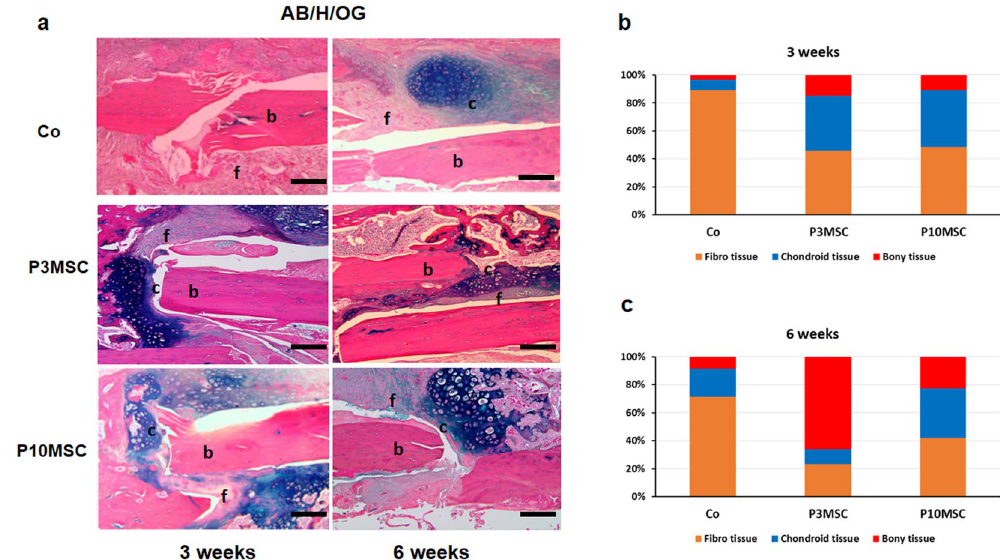
Figure 6. Enhanced chondrogenesis in aged MSC sheet wrapped allografts. ( a ) Representative images of callus between host bone and allograft in 3 groups. Histomorphometrical analysis of Alcian blue/Hema/Orange G (AB/H/OG) stained sections at 3 weeks (left) and 6 weeks (right) post-surgery. Specific regions are labeled as follows: b, bone; f, fibrous tissue; c, cartilage tissue. ( b ) Quantification of percentage of the bone, fibrous tissue, cartilage tissue in total callus at 3 weeks (n = 6). ( c ) Quantification of percentage of the bone, fibrous tissue, cartilage tissue in total callus at 6 weeks (n = 6). Scale bar, 400 um. * P <